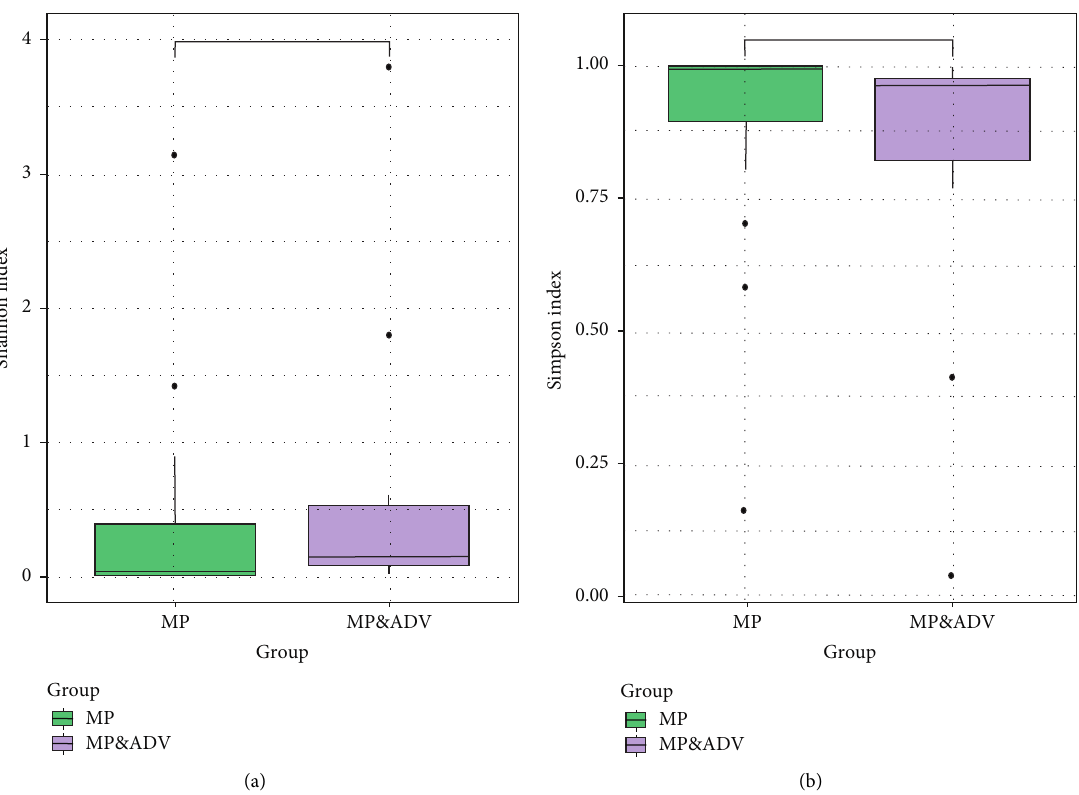
Figure 1: Comparison of the α -diversity of microbial communities between the MP and MP&ADV groups. Shannon’s index (a) and Simpson index (b) showed no significant difference between the two